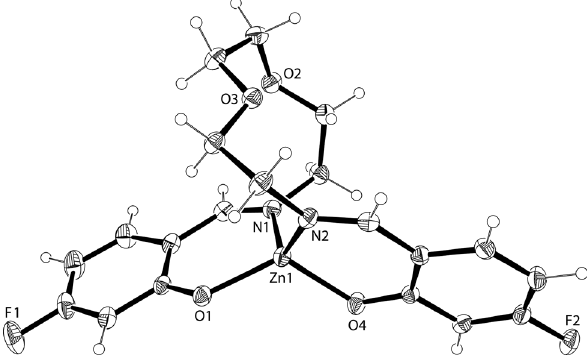
Table 1 contains crystallographic data and Table 2 contains the list of the atoms including atomic coordinates and displacement parameters.